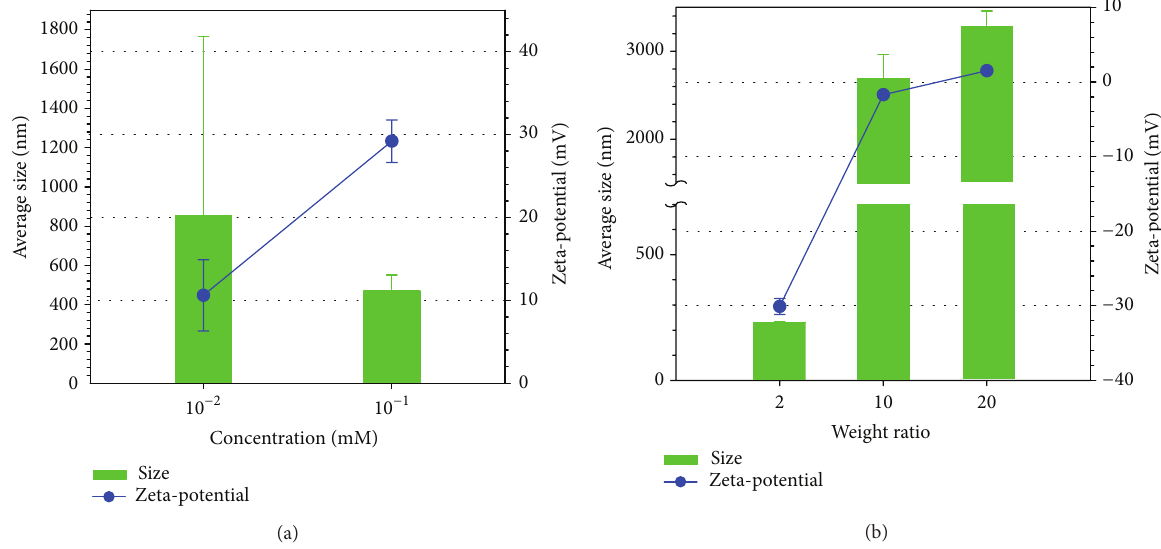
Figure 3: Average sizes and Zeta-potential values measurement results of MPD micelles (a) and MPD polyplexes (b).